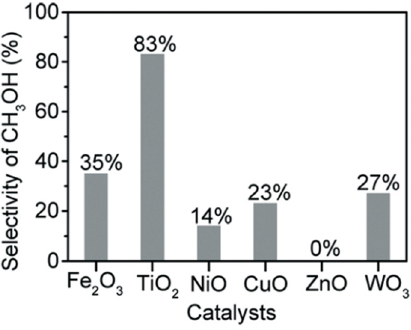
Figure 28. Methanol selectivity for different semiconductors [27]. Reproduced with permission from Zeng et al. Copyright © 2022 The Royal Society of Chemistry.